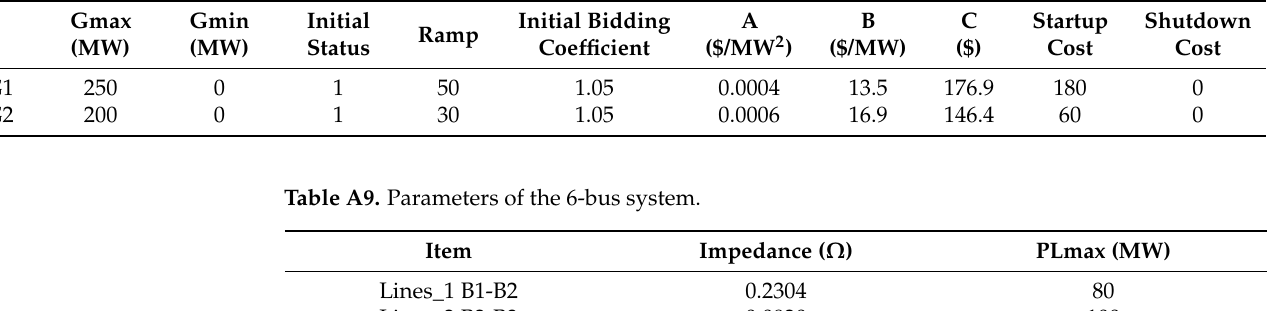
Table A8. Bidding parameters of power producers in the 6-bus system.